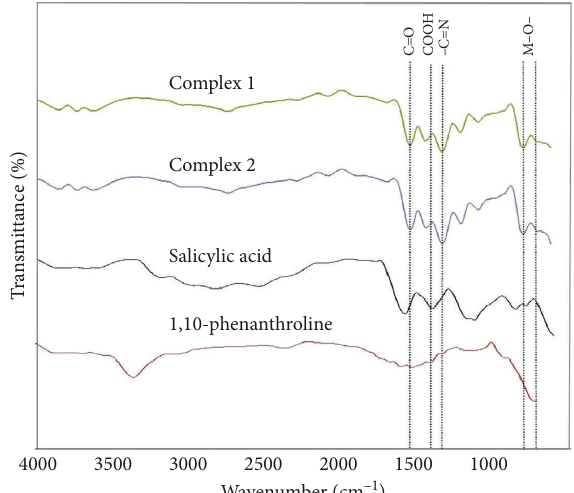
Figure 1: The FT-IR spectra of 1, 10-phenanthroline, salicylic acid, complexes (1) and (2).